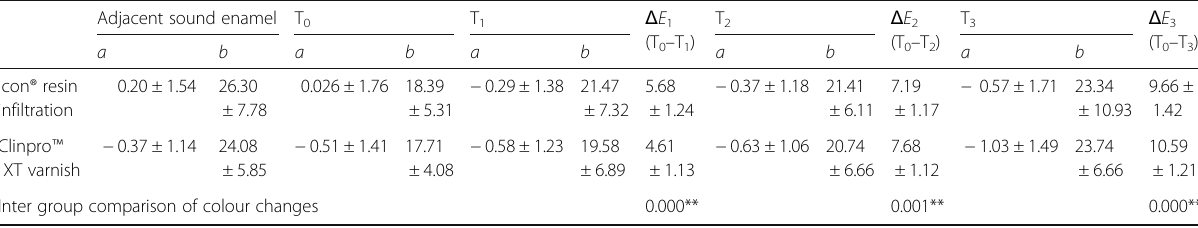
Table 3 a and b values and intergroup comparison of colour changes at various time intervals Adjacent sound enamel T 0